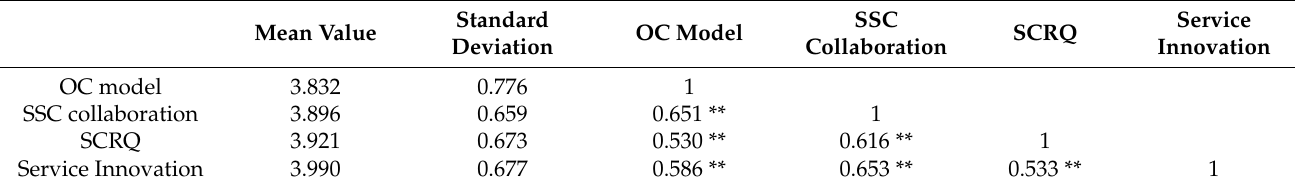
Table 4. Correlation between OC model, SSC collaboration and service innovation.